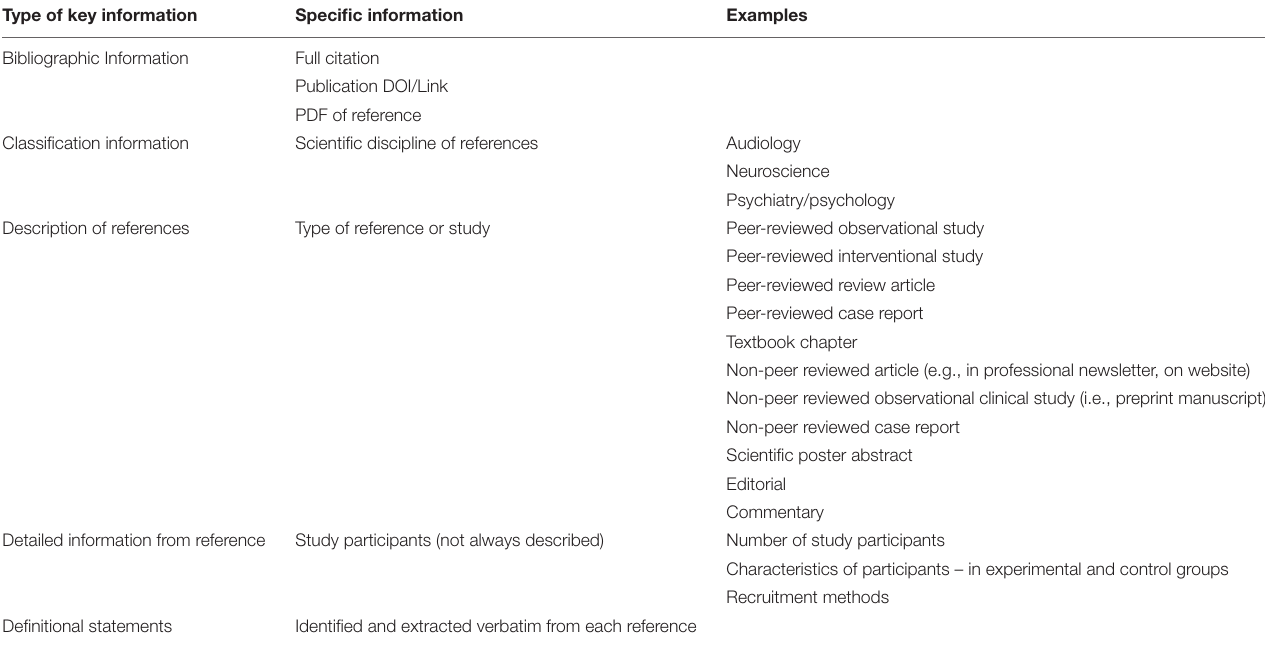
TABLE 2 | Key information extracted from a systematic review of the misophonia